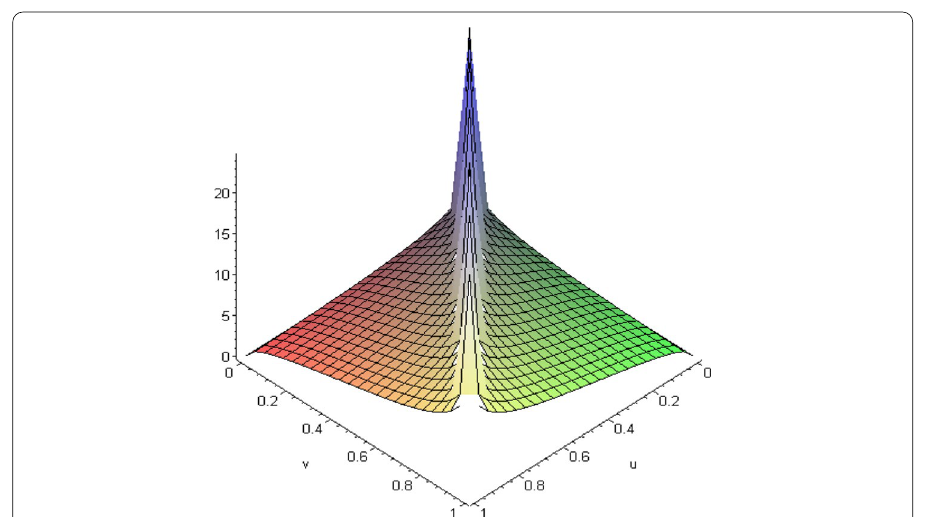
0.5, n 0 (elliptic = =